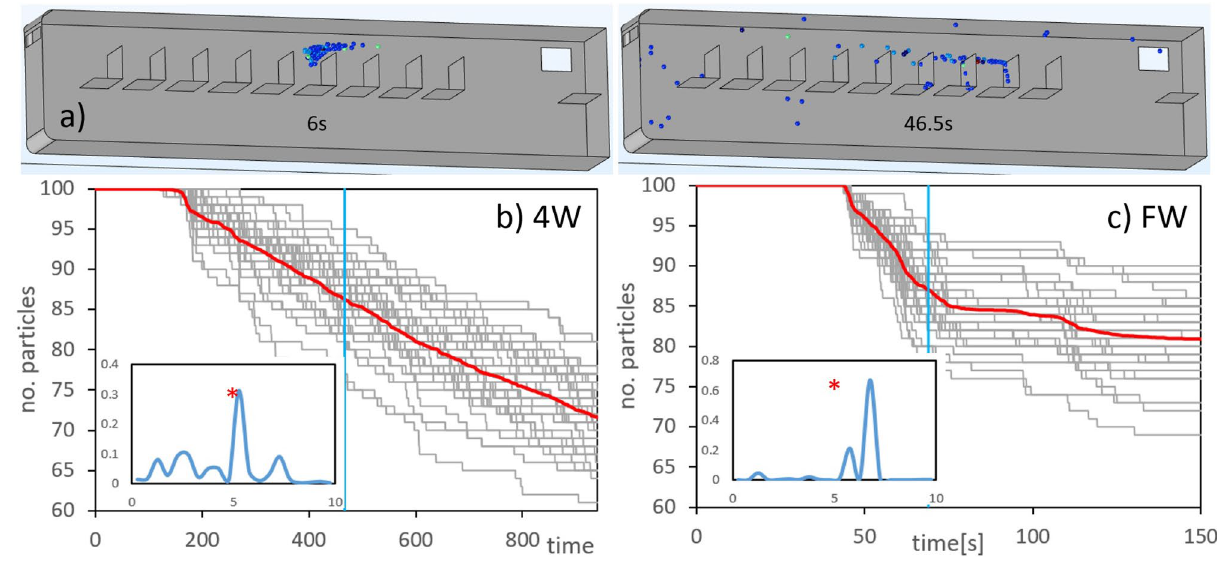
Figure 4. 3D particle tracking; ( a ) example of the location of 100 particles 6 and 46.5 s after emission; ( b ) and ( c ): number of particles inside the bus as a function of time (seconds) for every exhalation event (gray lines) and for the ensemble average (red line). The vertical blue line in the main plots indicates the maximum age of air values obtained for the 4W and FW cases; the insets show the pdf(y) of the particle position at the last time of the simulations, the asterisks indicate the position of the particles